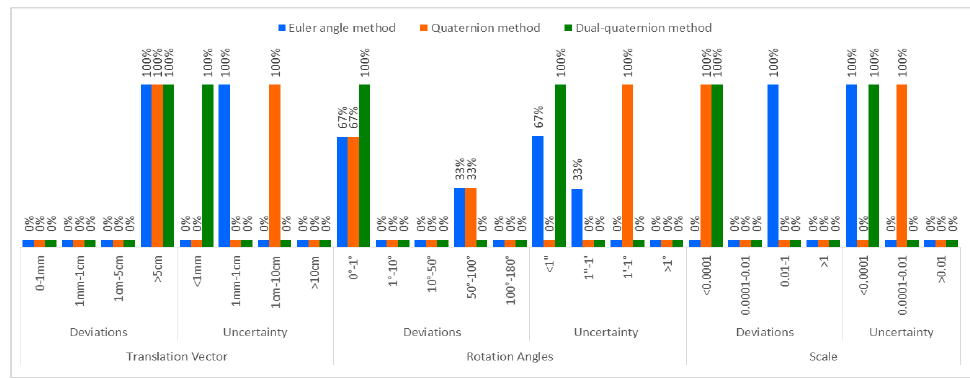
Figure 12. Histograms of deviations and uncertainty in the testing scenarios for all Helmert transformation parameters.